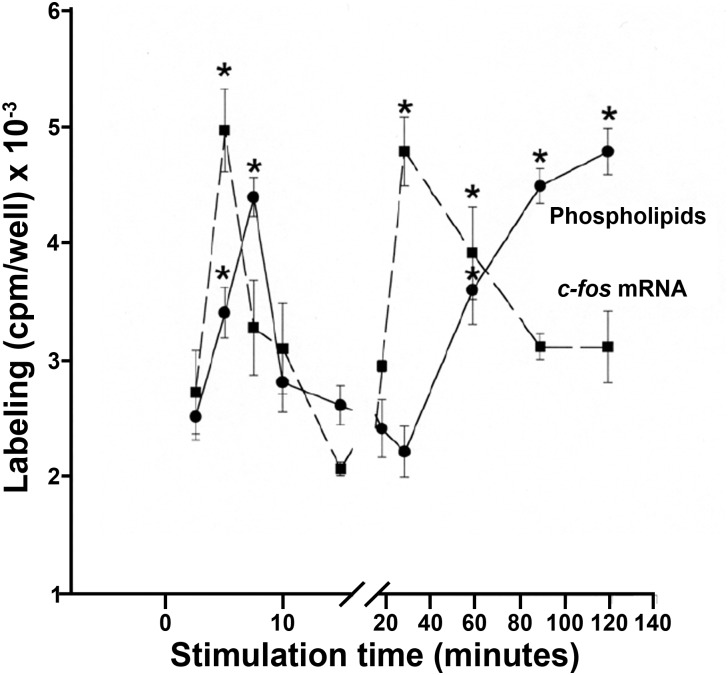
Time curves of phospholipid metabolic labeling (circles, full line) and c-Fos mRNA expression (squares, dashed line) in NIH-3T3 cells stimulated to re-enter cell cycle after quiescence. In all the conditions, phospholipid labeling was determined by pulsing cells with 32P-orthophosphate during 15 min, irrespective of the stimulation status. The results are the mean ± SD of six independent experiments performed in duplicate. ∗p < 0.025 with respect to time 0 of stimulation. Adapted from Bussolino et al., 2001 (the Copyright Clearance Center, Inc. grants authors rights to reproduce figures or tables from their own works free of charge).